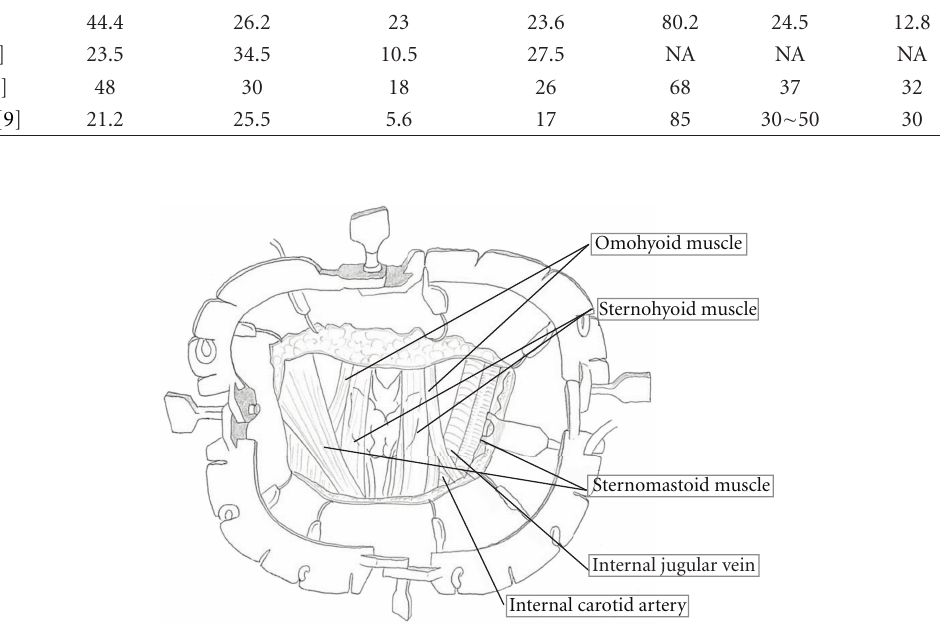
Figure 1: Lone Star Retractor System to make operative